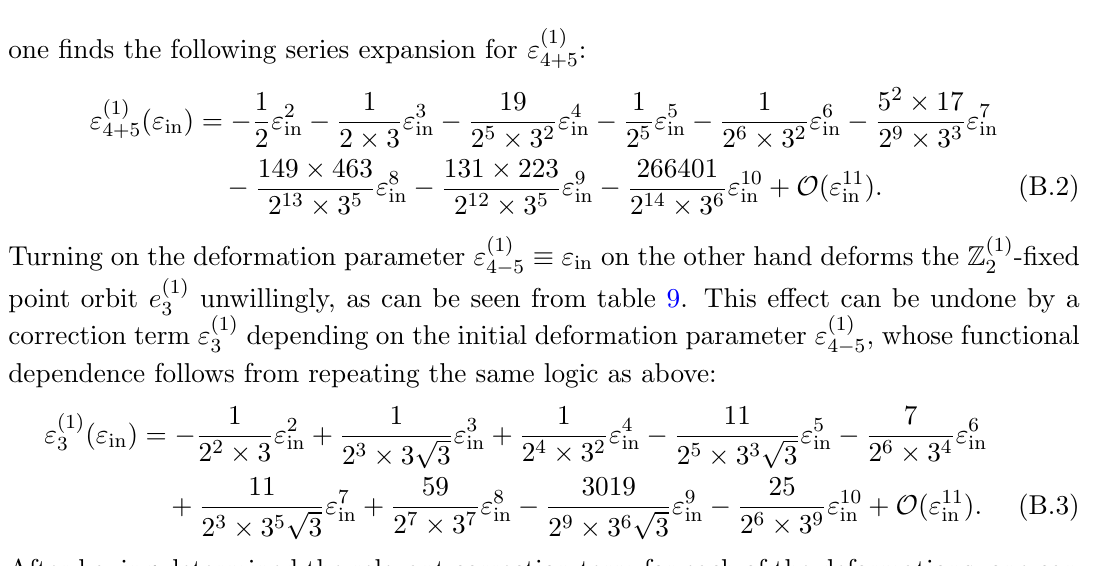
Table 28 . Overview of correction terms for various Z (1) sponding Taylor expansion indicated by the equations in the main